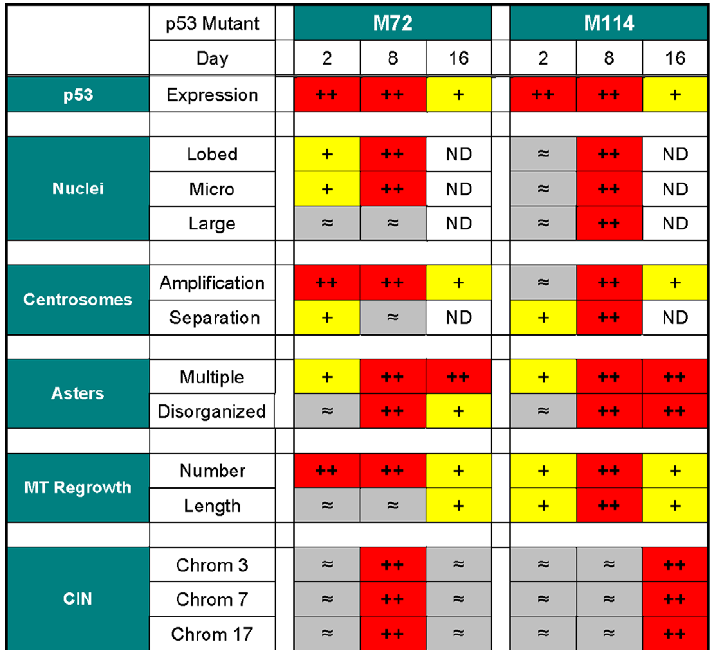
Timing of maximal effects of expression of p53